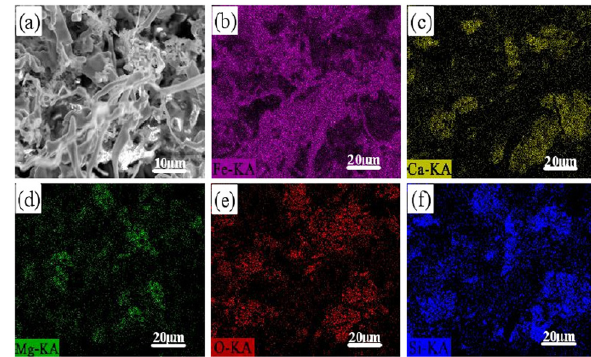
Figure 10: Distribution of main elements of briquette specimens after reduction at basicity of 0.8. ( a ) SEM - EDS image of briquette, ( b ) Fe - KA, ( c ) Ca - KA, ( d ) Mg - KA, ( e ) O - KA, and ( f ) Si - KA. ( b ) Fe - KA, ( c ) Ca - KA, ( d ) Mg - KA, ( e ) O - KA, and ( f ) Si